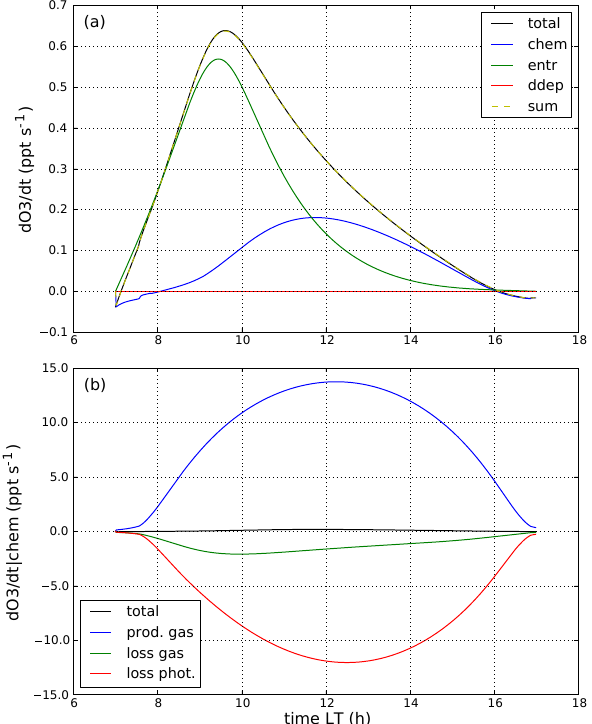
Figure 7. O 3 budget for the DOMINO case showing the contribu- tions of (a) the processes entrainment, chemistry and dry deposition and (b) the chemical production and loss with the chemical loss split up in a gas-phase destruction and a photolysis